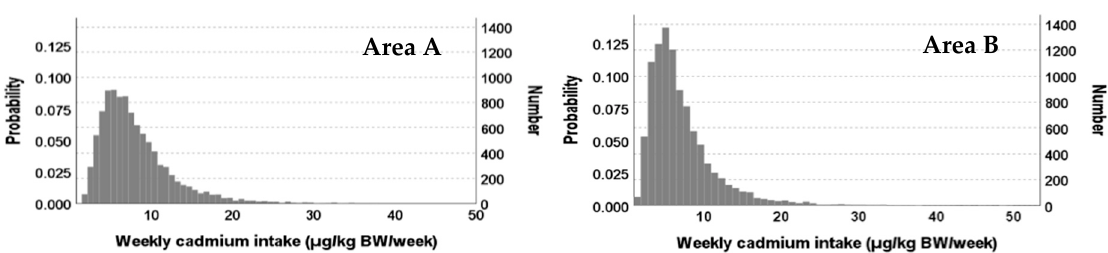
Figure 4. Probability density distributions of weekly cadmium intake per body weight in female farmers in cadmium-polluted areas A and B in Akita, Japan, estimated using the Monte Carlo simulation. Table 15. Results of the Monte Carlo simulation for weekly cadmium intake per body weight (µg/kg BW/week) in female farmers in areas A and B.